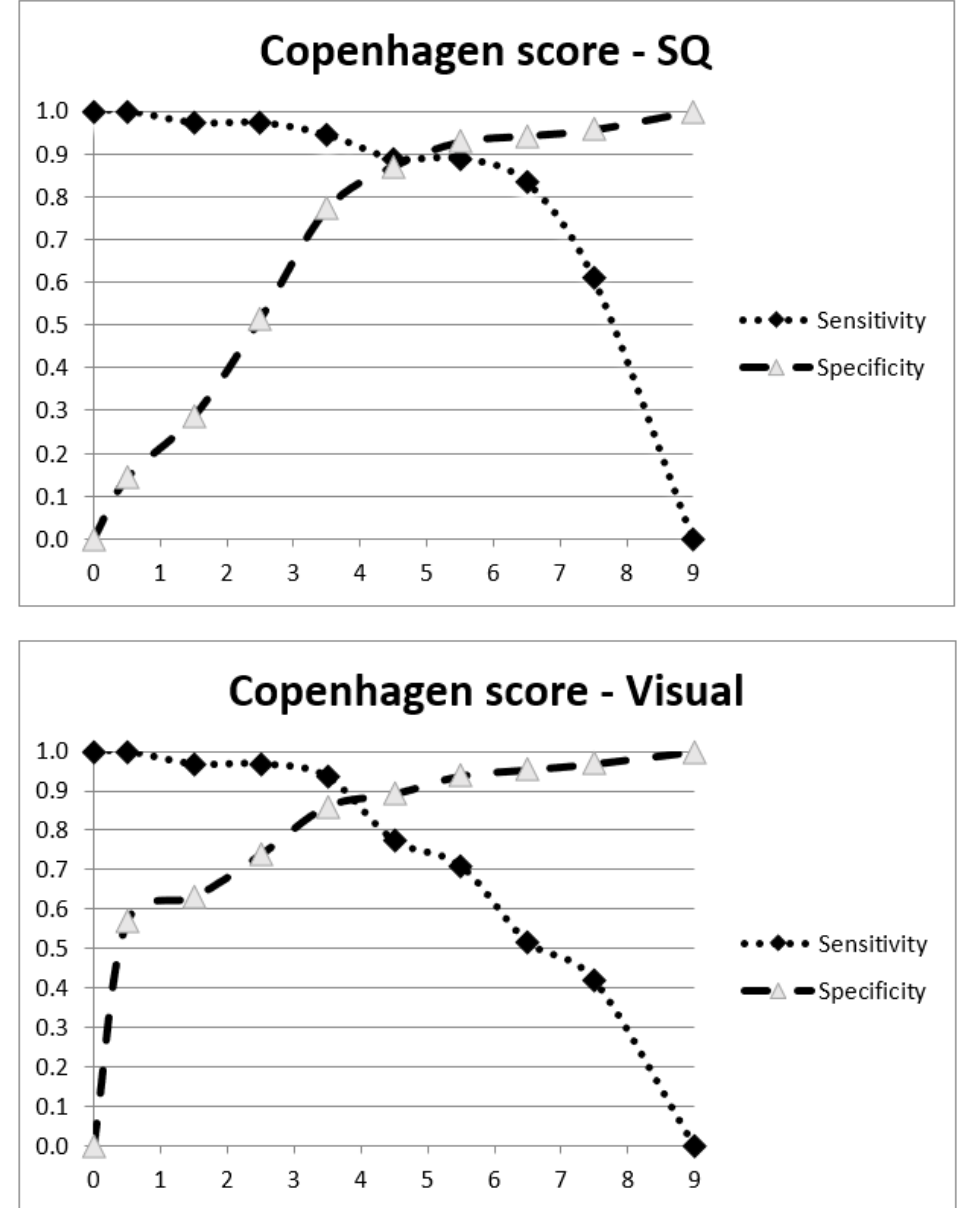
Figure 1. Plots of sensitivity and specificity for the semiquantitative (SQ) and visual (Visual) Copen- hagen score in steroid-naïve patients.